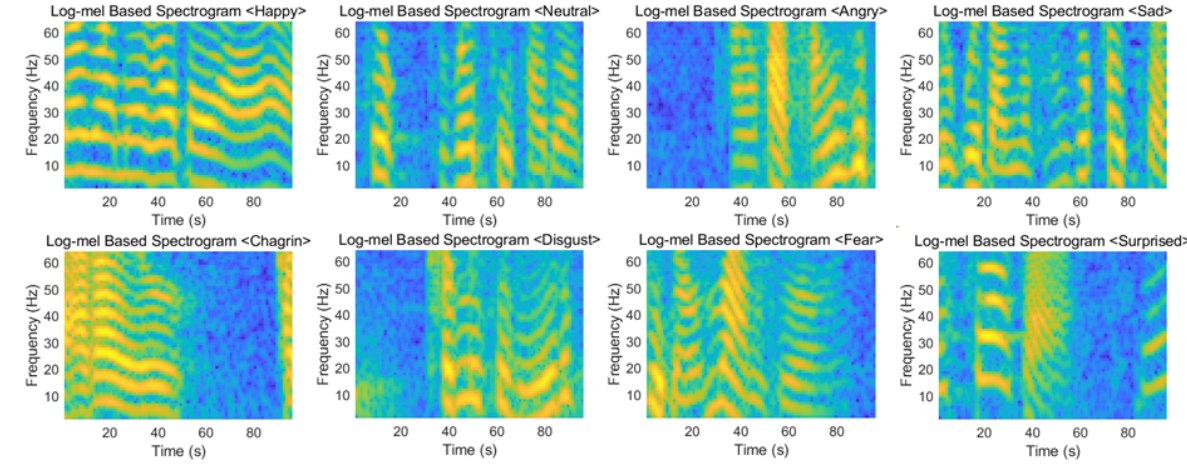
Figure 3. Visualization of log-mel spectrograms for eight emotions.